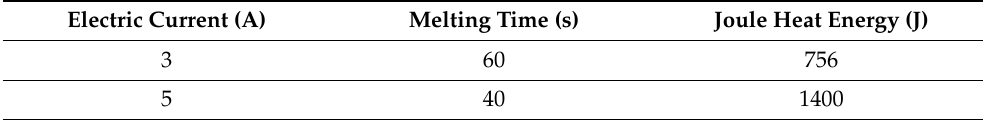
Figure 8. The experimental set-up for the deicing test of the CF/EP composite plate. Table 1. The deicing behavior of the CF/EP composite under different current loading.